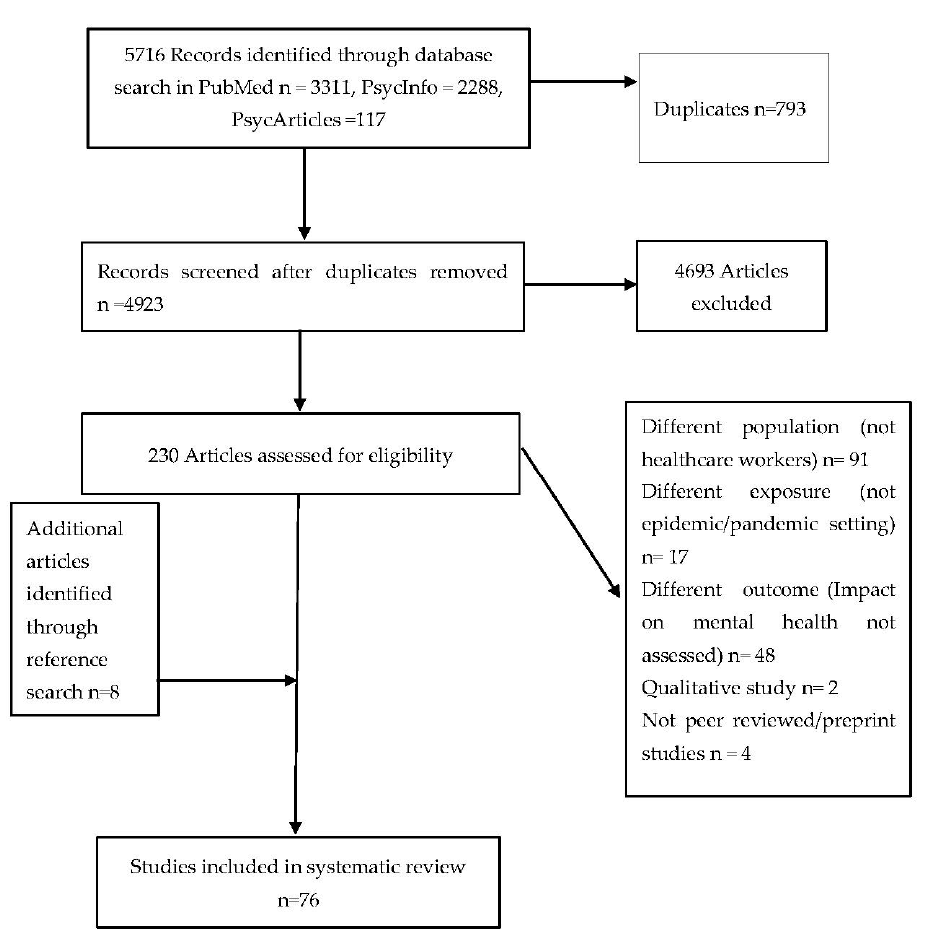
Figure 1. PRISMA flow diagram of studies selected for inclusion in systematic review.